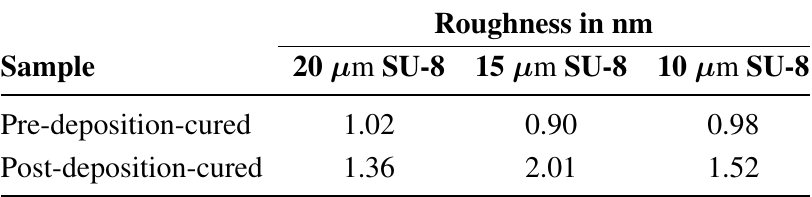
Table 2. Roughness values for 12 nm thick gold films on pre- and post-deposition cured samples with different thickness of SU-8